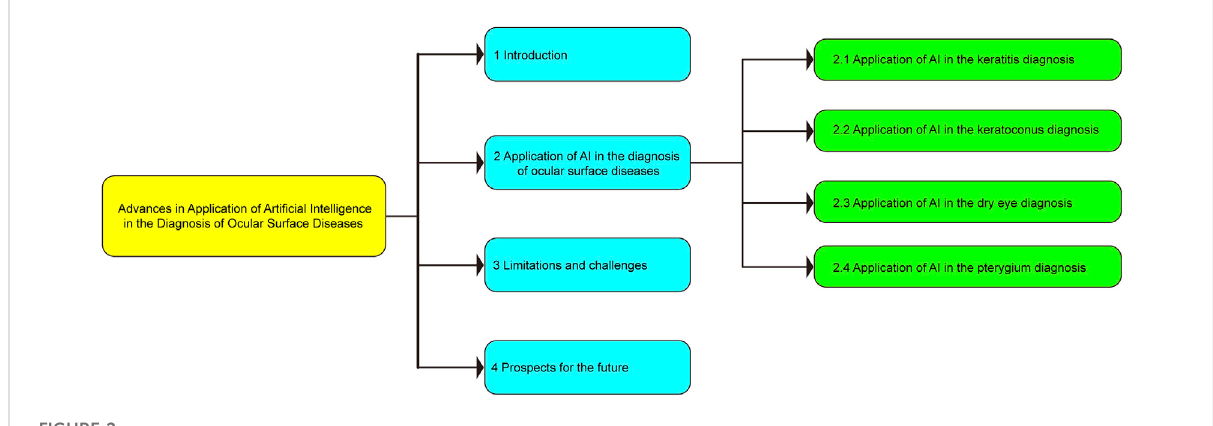
FIGURE 2 Basic framework of this